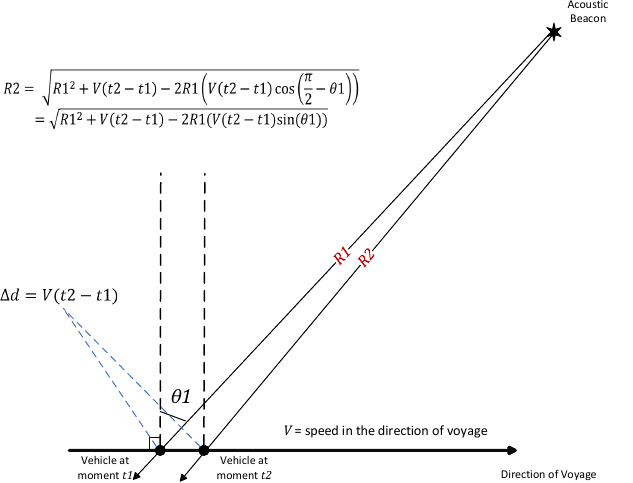
Figure 3. The relation of the distance between the vehicle and the beacon at two different